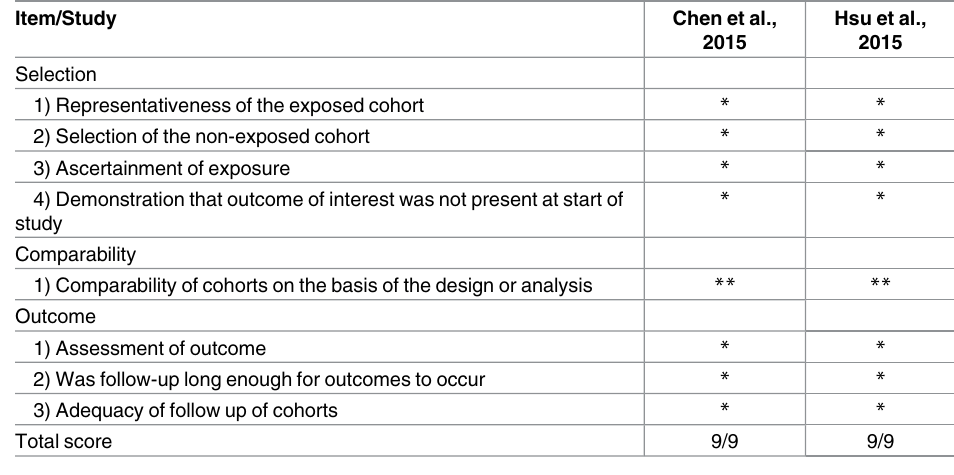
Table 2. Risk of bias assessment of cohort studies.